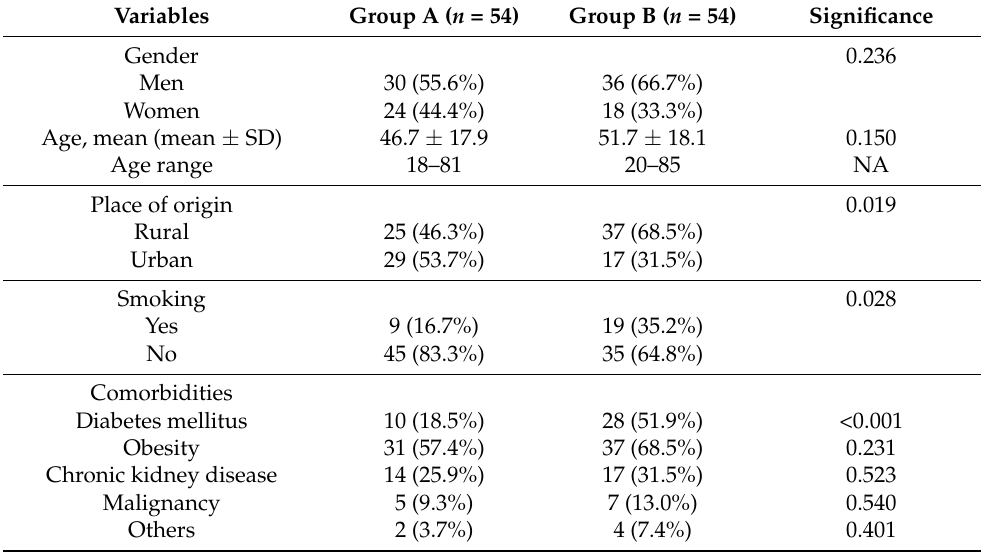
Figure 1. Patients’ inclusion flowchart. Table 2. Comparison of background characteristics among patients with odontogenic infections.